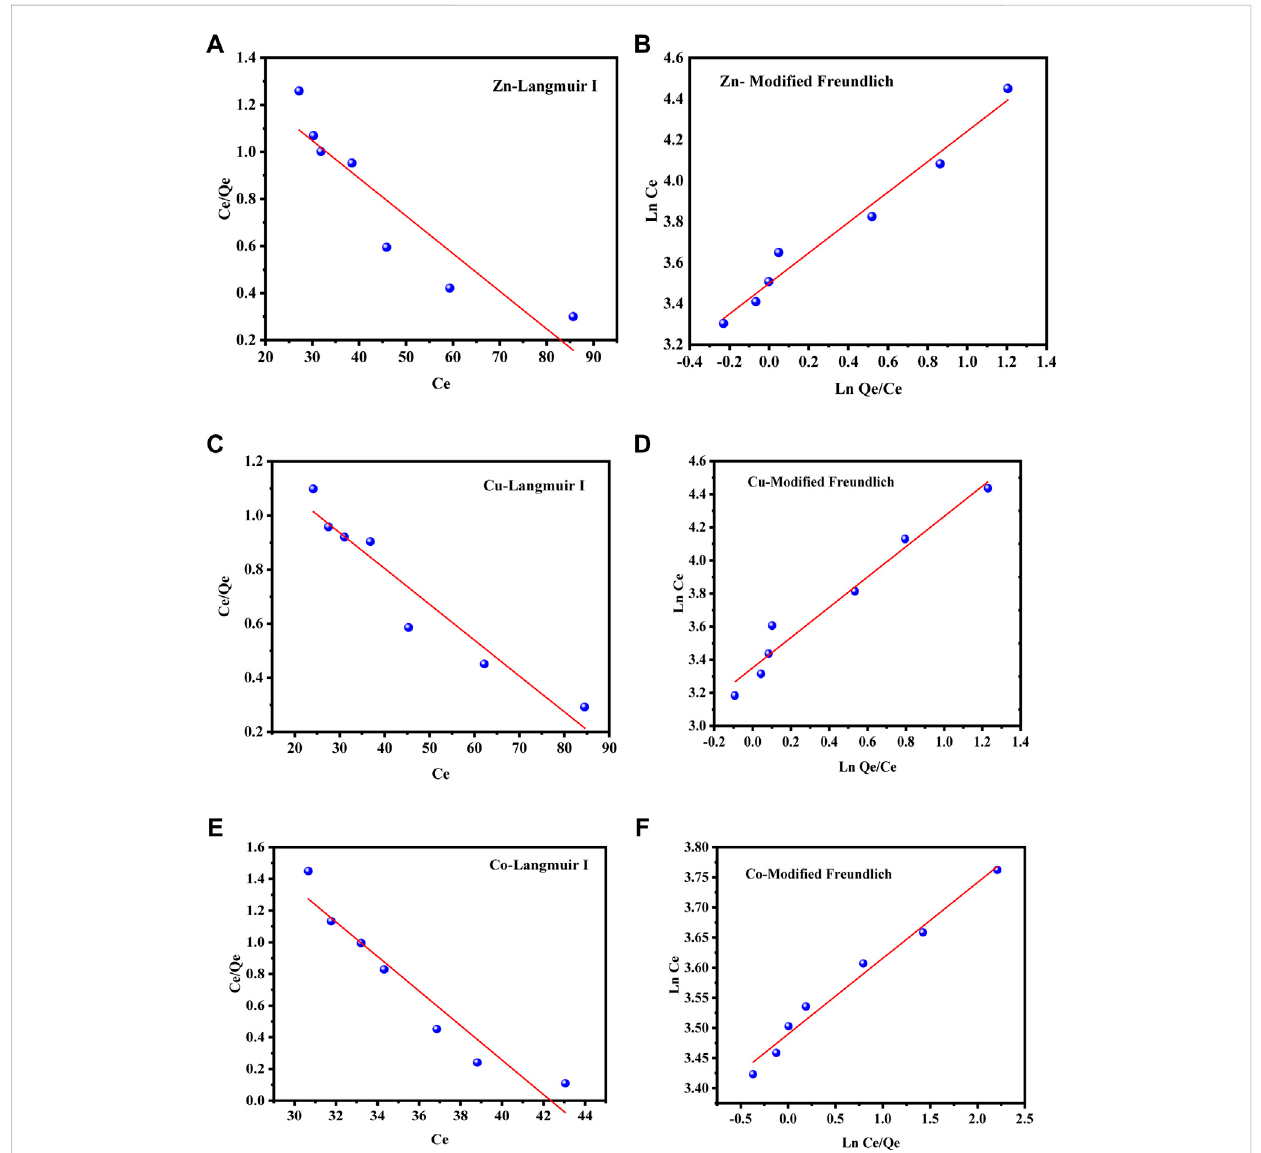
FIGURE 6 (A – F) Langmuir and Freundlich isotherm sorption models of Zn(II), Cu(II), and Co(II) on SBL from aqueous